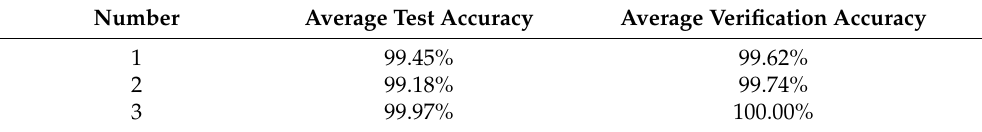
Table 7. Results of five round crossover experiments with different numbers of vibration signals.